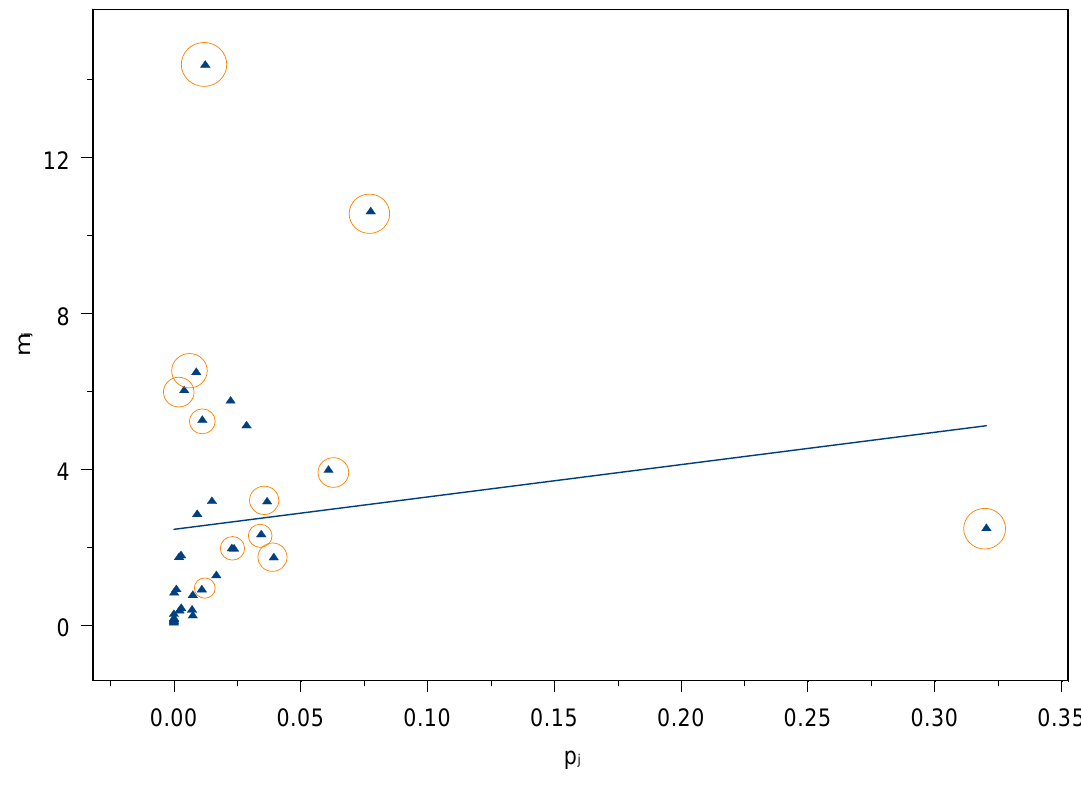
Figure 1. Regression model with all the 33 subpopulations of known size. The circles highlight the subpopulations that were eliminated with the analysis of